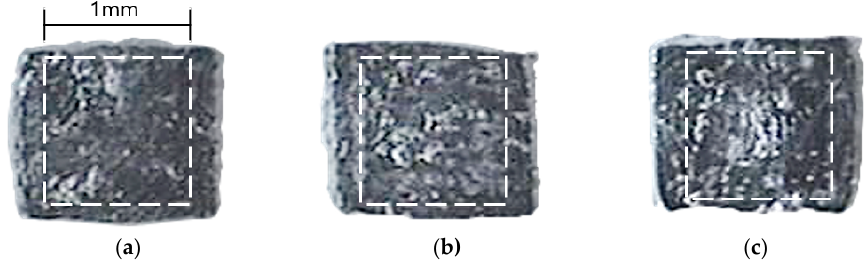
Figure 4. Examples of specimens after small-cube compression test: ( a ) Y 0 , ( b ) Y 45 , ( c ) Y 90 . Table 1. Measured values of compressed small-cube specimens.